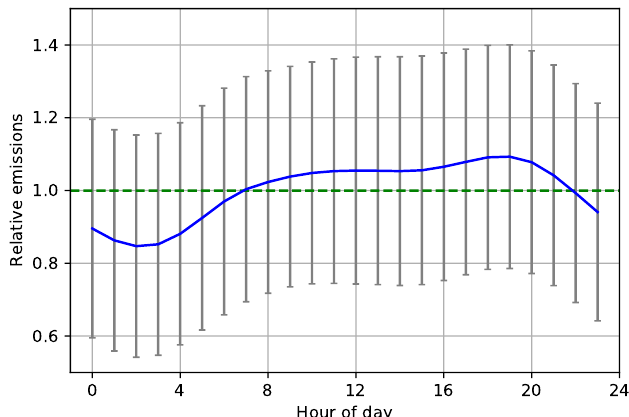
Figure 15. Hourly scale factors for 50 highest emitting US power plants, using 2018 data. Error bars show the standard deviation in the binned hourly relative